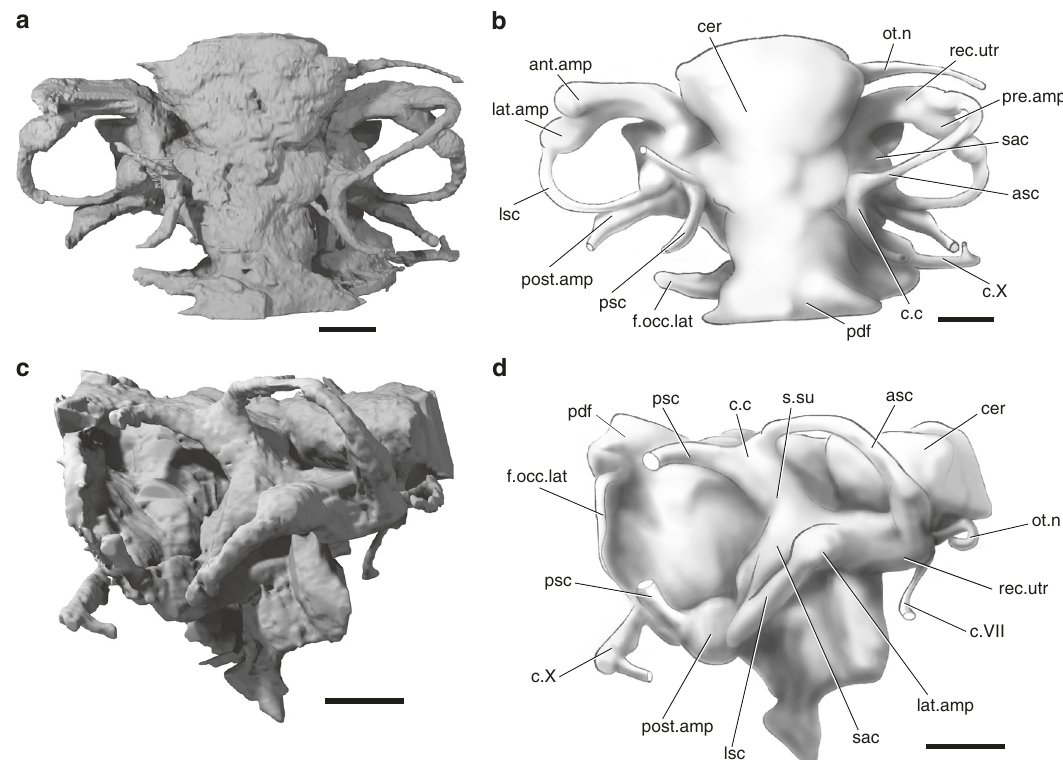
Fig. 2 Digital neurocranial endocast of Ptyctolepis brachynotus gen. et sp. nov. a Rendering and b interpretive drawing in dorsal view; c Rendering and d interpretive drawing in right lateral view. ant.amp ampulla of anterior semicircular canal, asc anterior semicircular canal, cer cerebellum, c.c crus commune, c.VII facial nerve, c.X vagus nerve, f.occ.lat lateral occipital fi ssure, lat.amp ampulla of lateral semicircular canal, lsc lateral semicircular canal, ot. n otic lateral line nerve, pdf posterior dorsal fontanel, post.amp ampulla of posterior semicircular canal, pre.amp preampullary canal, psc posterior semicircular canal, rec.utr utricular recess, sac sacculus, s.su sinus superior. Scale bar, 5